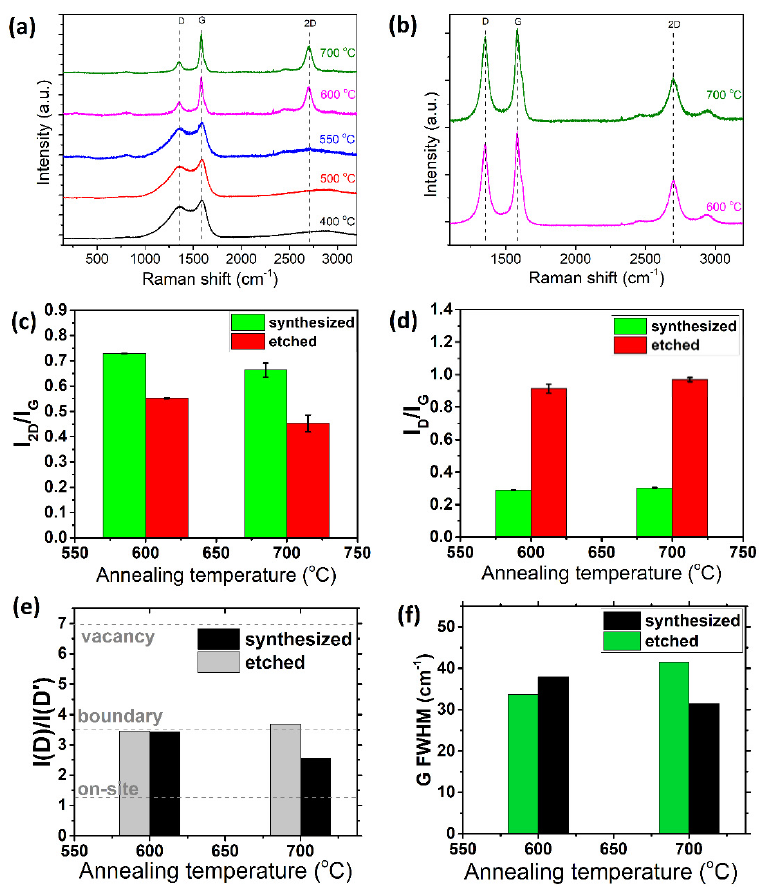
Figure 7. The annealing temperature effects on the structure of graphene grown by a two-step synthe- sis: the Raman spectra after the synthesis ( a ) and after removing the sacrificial cobalt interlayer ( b ); Raman spectra parameters analyzed: I 2D /I G ( c ); I D /I G ( d ); I D /I D’ ( e ); FWHM(G) ( f ). I 2D /I G ratios range from 0.65 to 0.73, corresponding to multilayer graphene